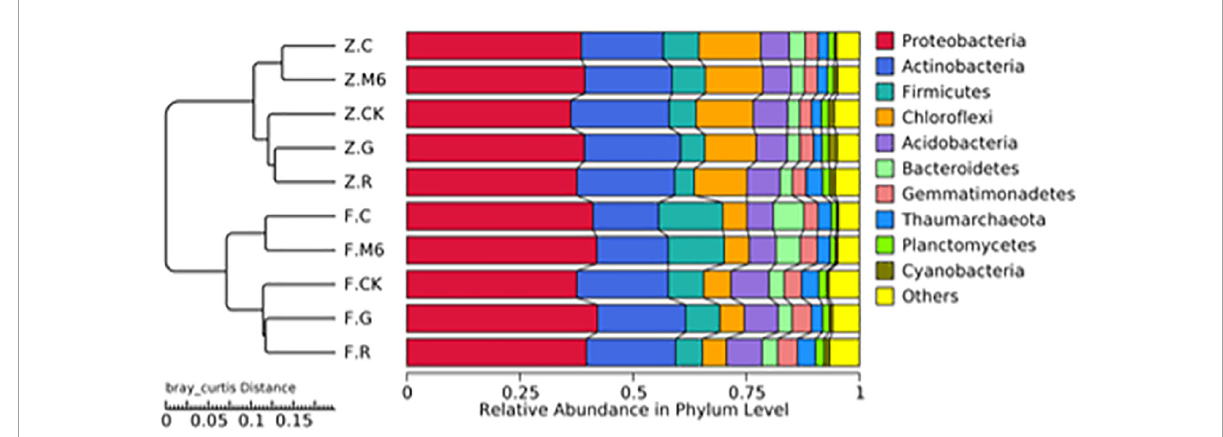
FIGURE4 The cluster dendrogram of Bray-Curtis dissimilarity of samples. CK, control; M6, M6 strain; C, M6 + Biochar; G, M6 + Glutamic acid; R, M6 + rhamnolipid; F, Fuyang County; Z, Zhuji